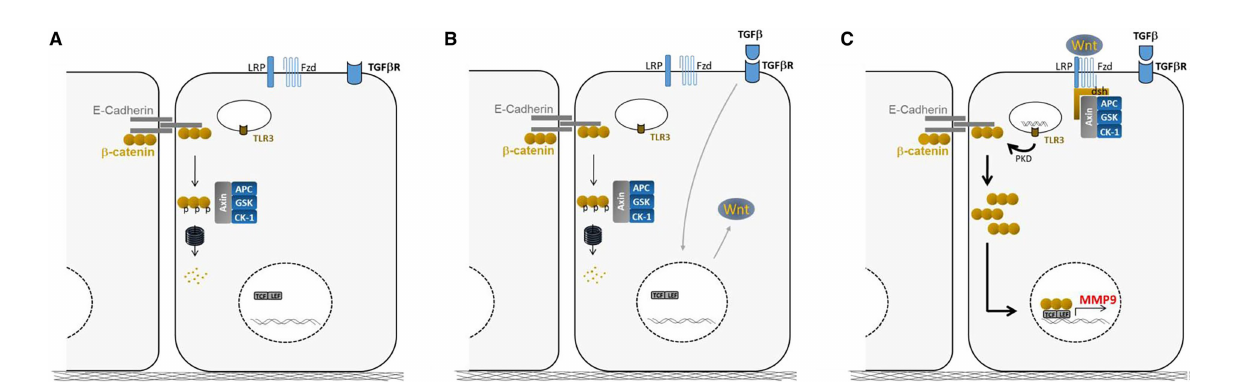
FIGURE 9 Summary of the main findings. (A) Steady-state: cytosolic β -catenin is phosphorylated by the GSK complex and targeted to the proteasome for degradation. (B) Wnt ligand production after TGF- β exposure stabilizes the GSK complex at the cell membrane and reduces β -catenin degradation. (C) Then, the massive relocation of β -catenin after poly (I: C) treatment, fuels the Wnt/ β -catenin pathway and allows β -catenin translocation in the nucleus for MMP-9 expression adapted from